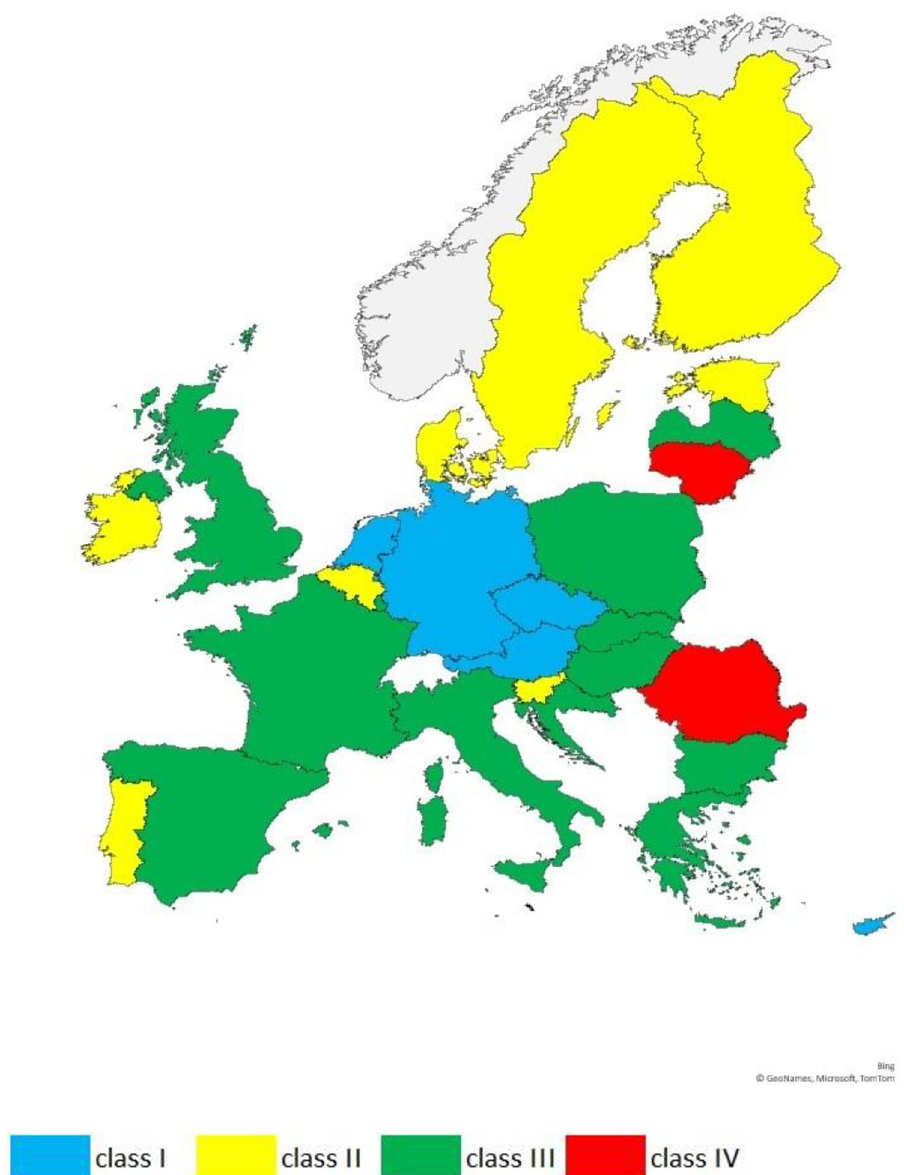
Fig 1. Spatial diversification of EU-28 countries in terms of relative economic anchor level in